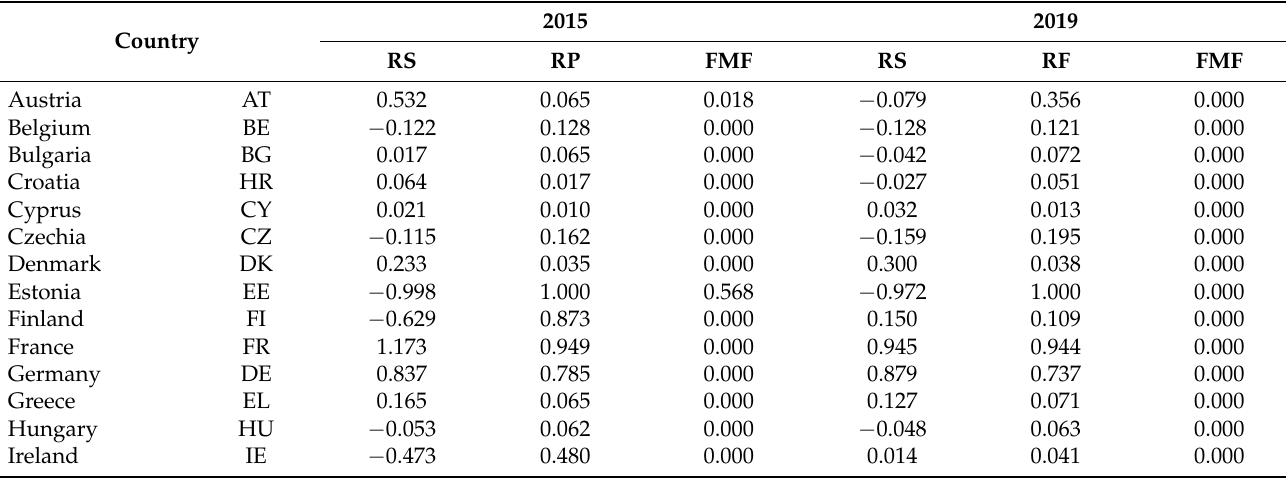
Table 4. Relations of a selected part of MULTIMOORA procedure-related management of renewable energy consumption in EU countries (2015 vs.